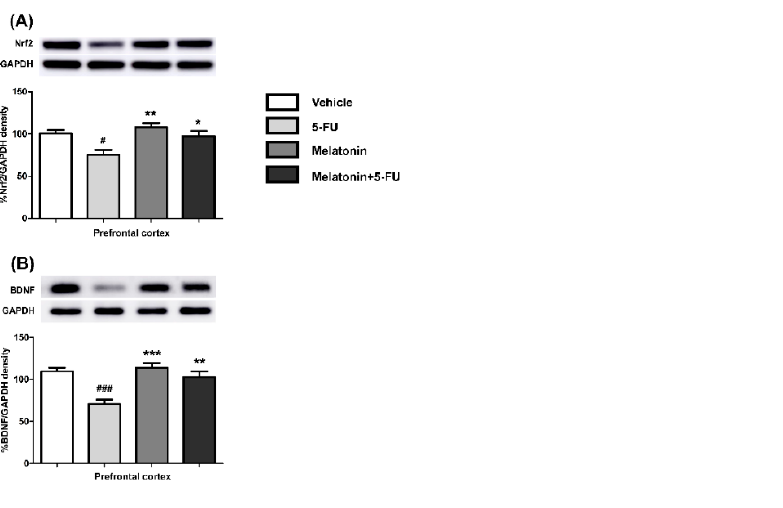
Figure 6. Nrf2 ( A ) and BDNF ( B ) protein expression in the PFC. # p < 0.05 and ### p < 0.001 compared with the vehicle group. * p < 0.05, ** p < 0.01 and *** p < 0.001 compared with the 5-FU group. Doublecortin: DCX; nuclear factor erythroid 2-related factor 2: Nrf2; brain derived neurotrophic factor: BDNF.